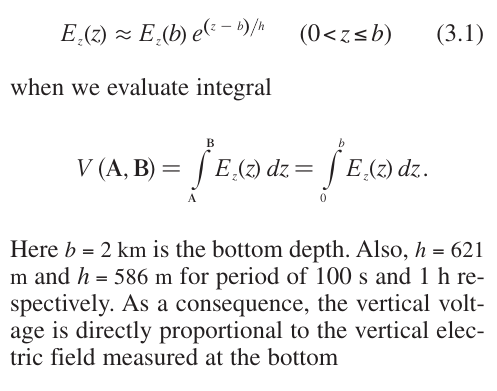
Table I. Absolute value of E z -response, | u zy | , with respect to the fault resistivity and period. E z -response (mV / nT) 100 s